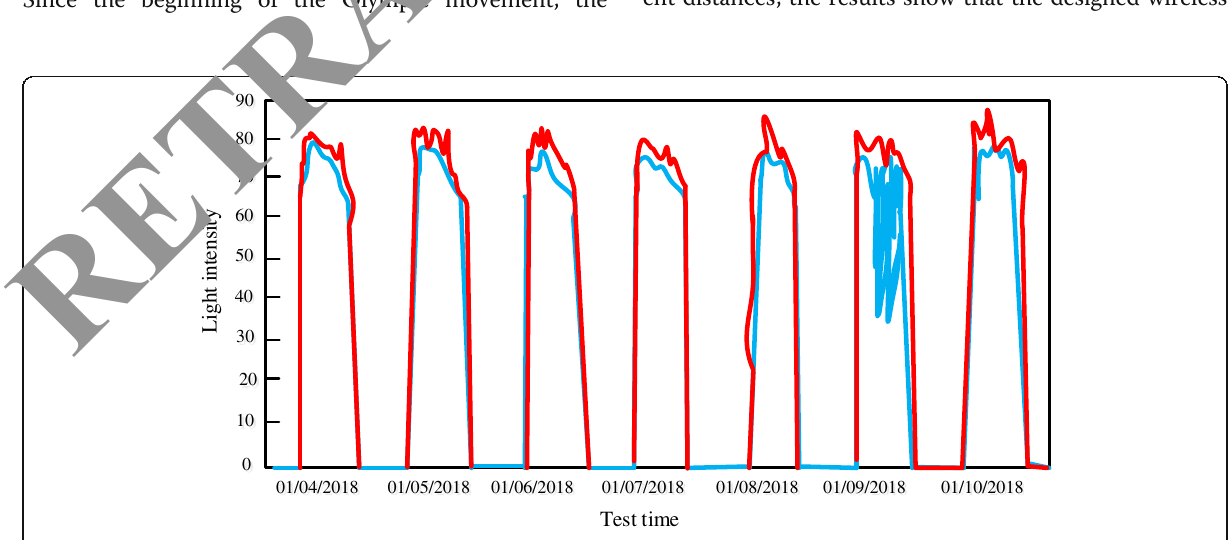
Fig. 7 The data curve of ambient light intensity collected by the